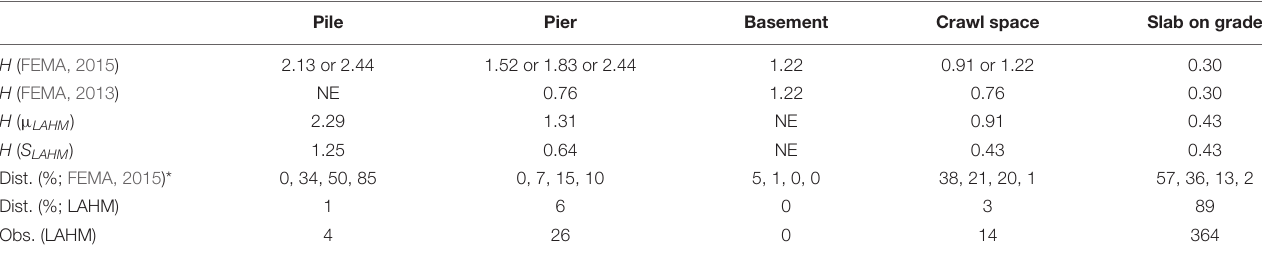
TABLE 10 | H (m) for the FEMA, 2013 and FEMA, 2015 foundation types in Louisiana vs. LAHM foundation